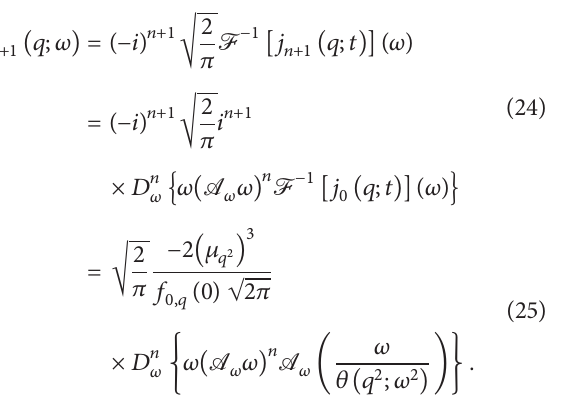
Figure 1: (a) 𝑞 = 1.20 and is compared with 𝑃 which is